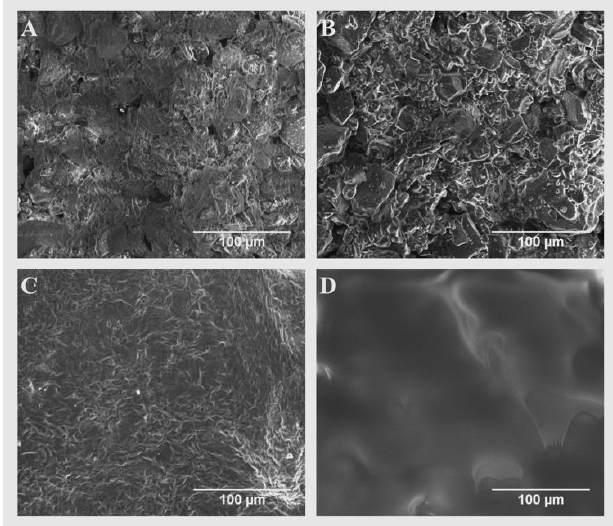
Figure 7. The SEM micrographs of the untreated and coated preform tablet surfaces. ( A ) Surface of untreated preform tablet. ( B ) Bottom compartment infused with a 10% E-100 in acetone solution. ( C ) Top compartment infused with a 15% PEG (35 kDa) in acetone solution. ( D ) Inner section of the top compartment preform tablet, brushed with a 20% E-100 in acetone solution.